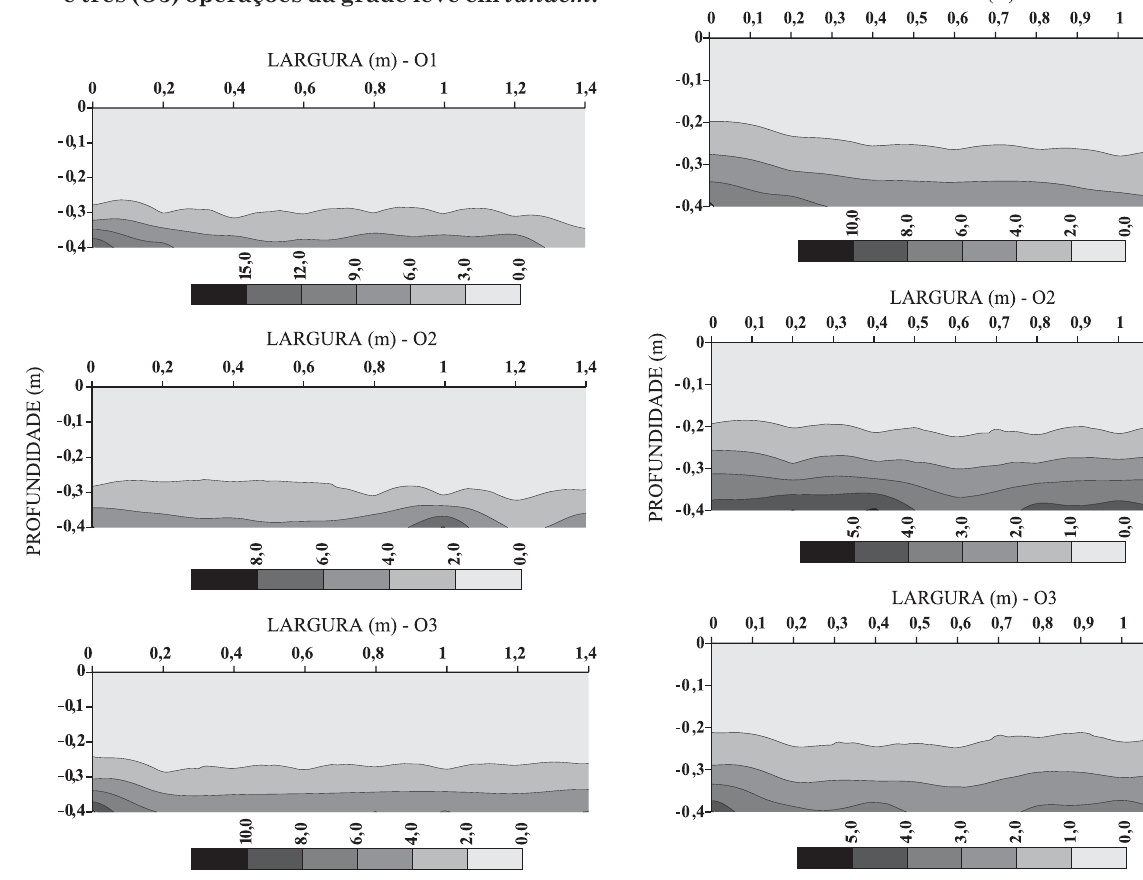
diâmetro.Figura 3. Mapa de isolinhas do atributo RP (MPa) no perfil do solo preparado com uma (O1), duas (O2) e três (O3) operações da grade leve em tandem .